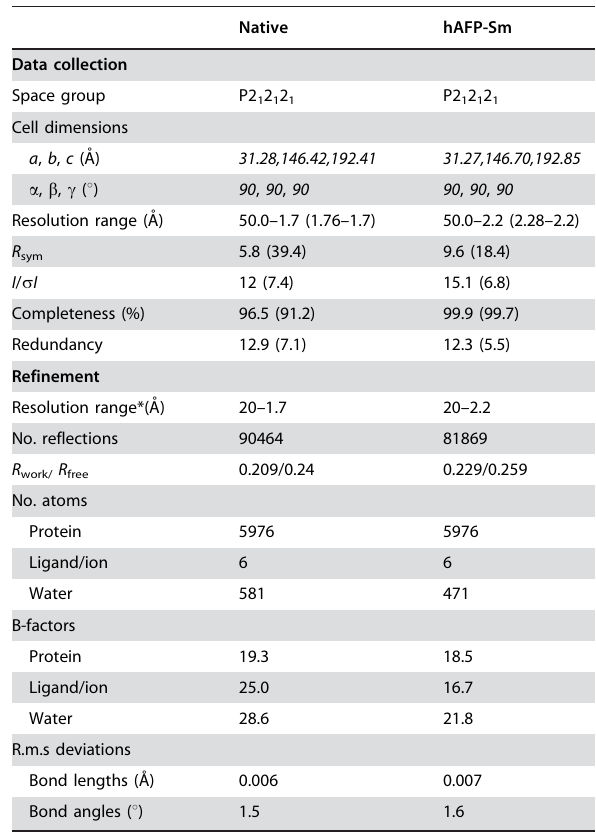
Table 1. Data collection, phasing and refinement statistics. ... ... ... .... ... ... .... ... ... .... ... ... .... ... ... .... ... ... .... ... ...